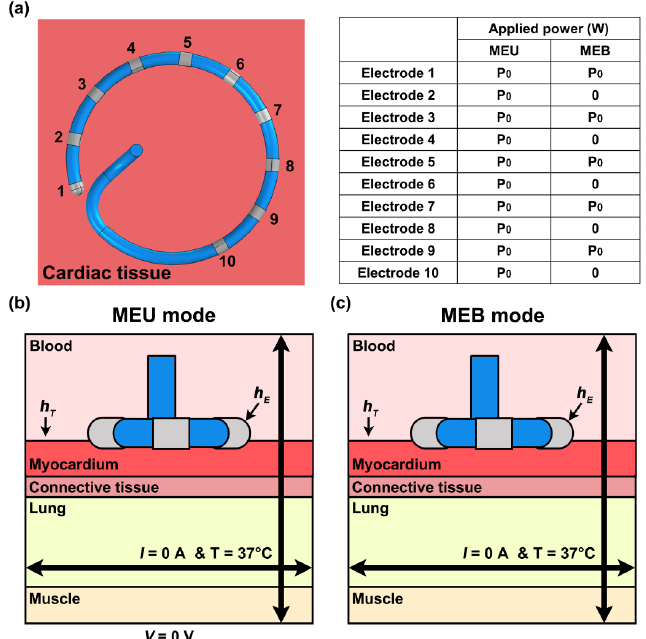
Table 1. Thermal and electrical properties of human and porcine